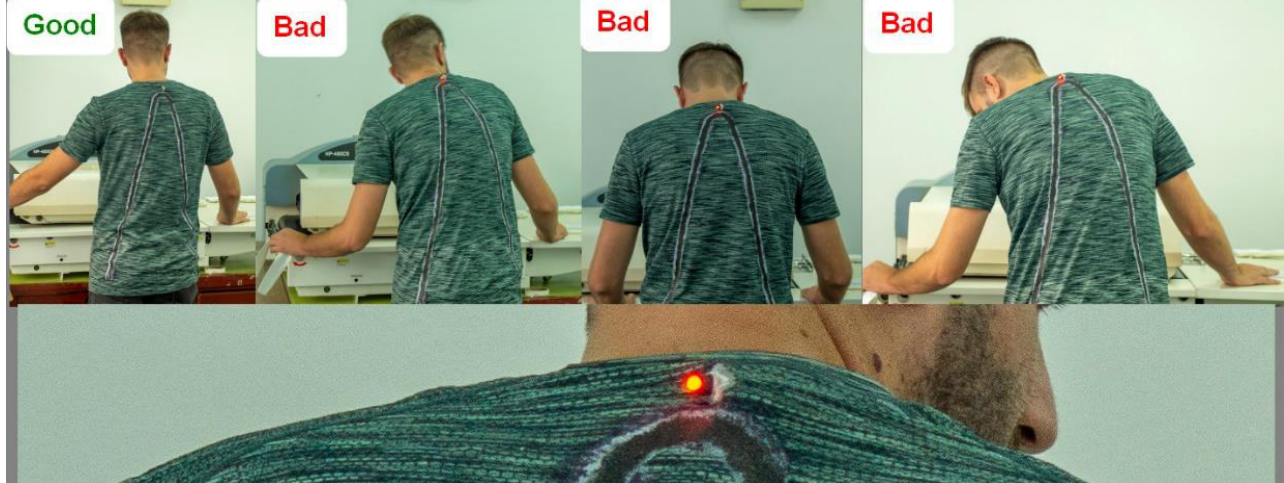
Figure 6. Assessed activity and wearable’s LED signaling when the person is in a risk-prone pos-